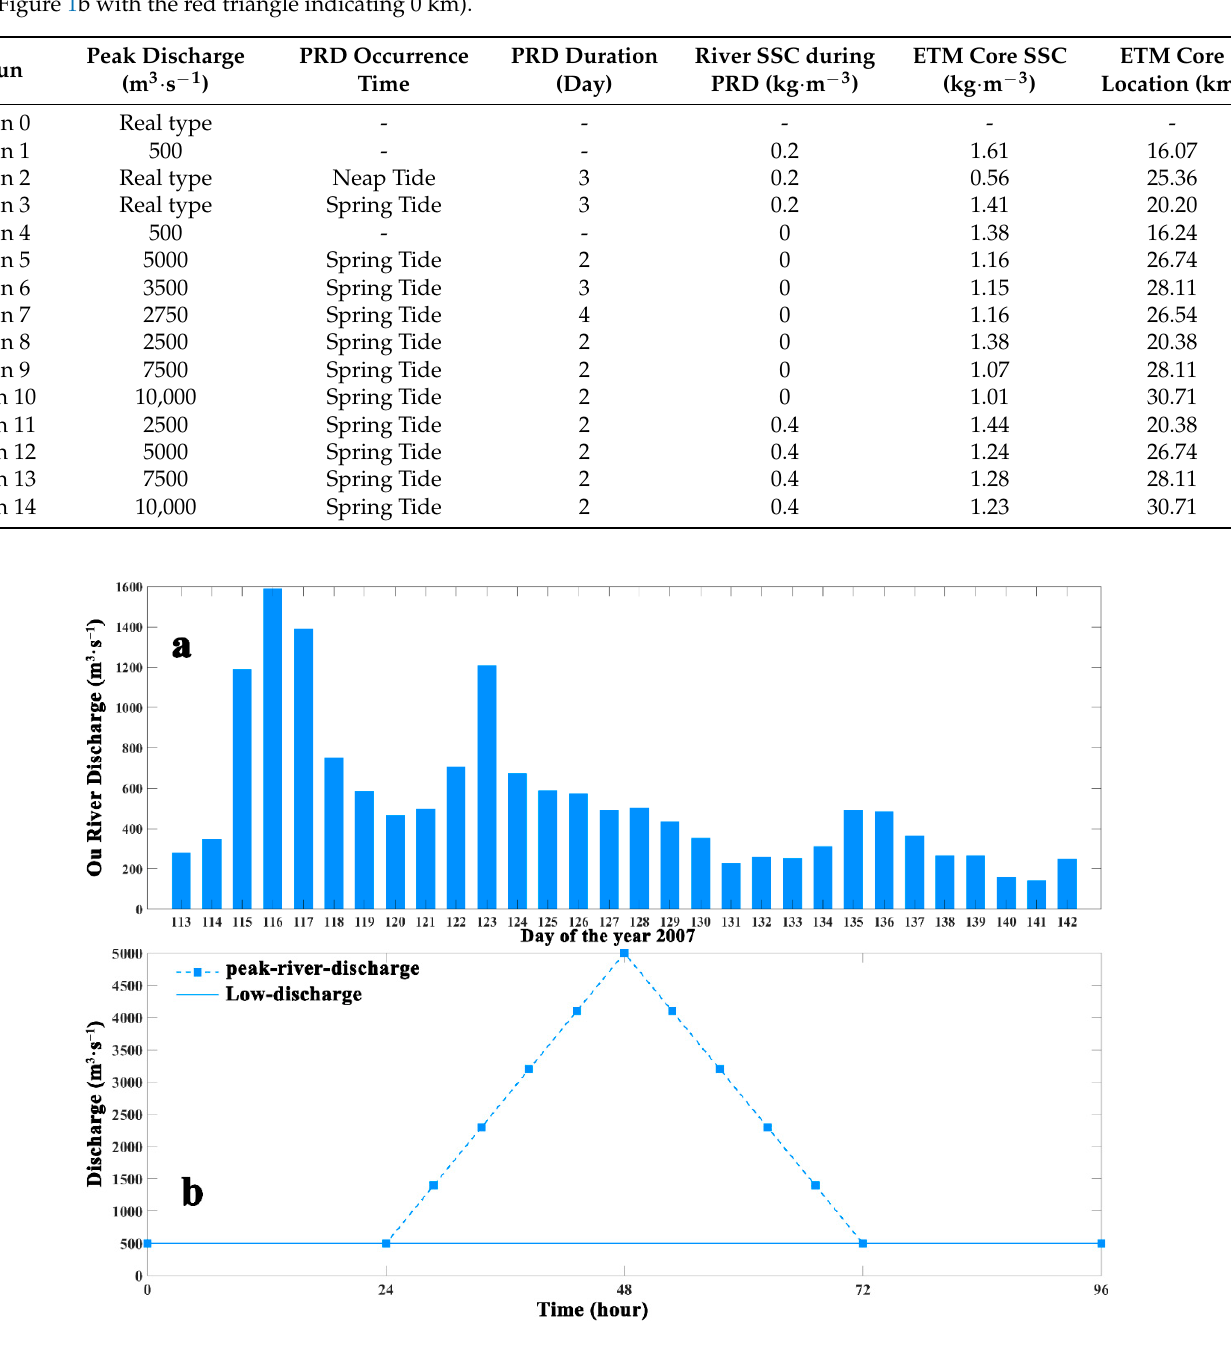
Figure 7. ( a ) River discharge of the OR during the in-situ measurement. ( b ) Two types of river discharge (blue lines) in experiment runs: the solid line is for low-discharge, the dashed line with squares is for PRD. Table 4. Experiment configuration and the SSC and location of the ETM core in the along-channel section (the red line in Figure 1b with the red triangle indicating 0 km).